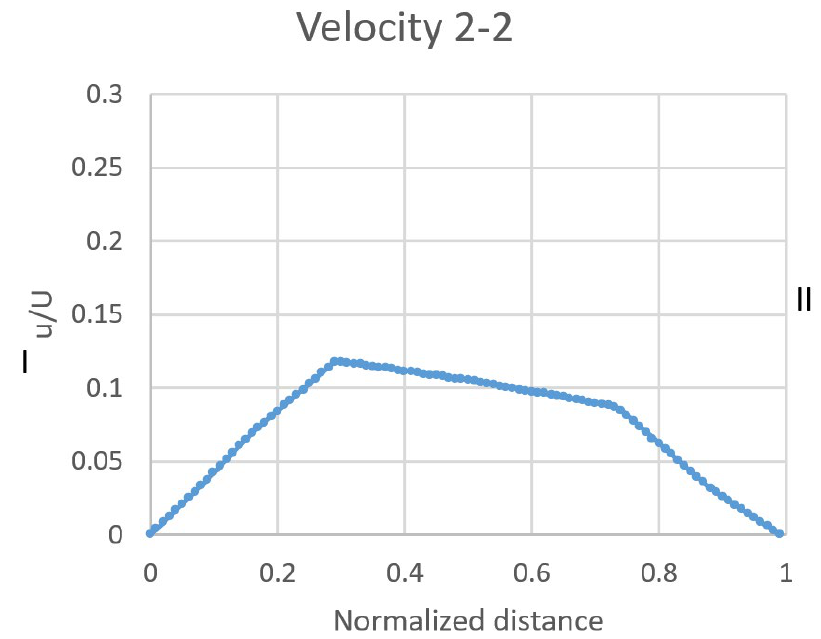
Figure 8. Velocity profile at the upstream section (1-1).